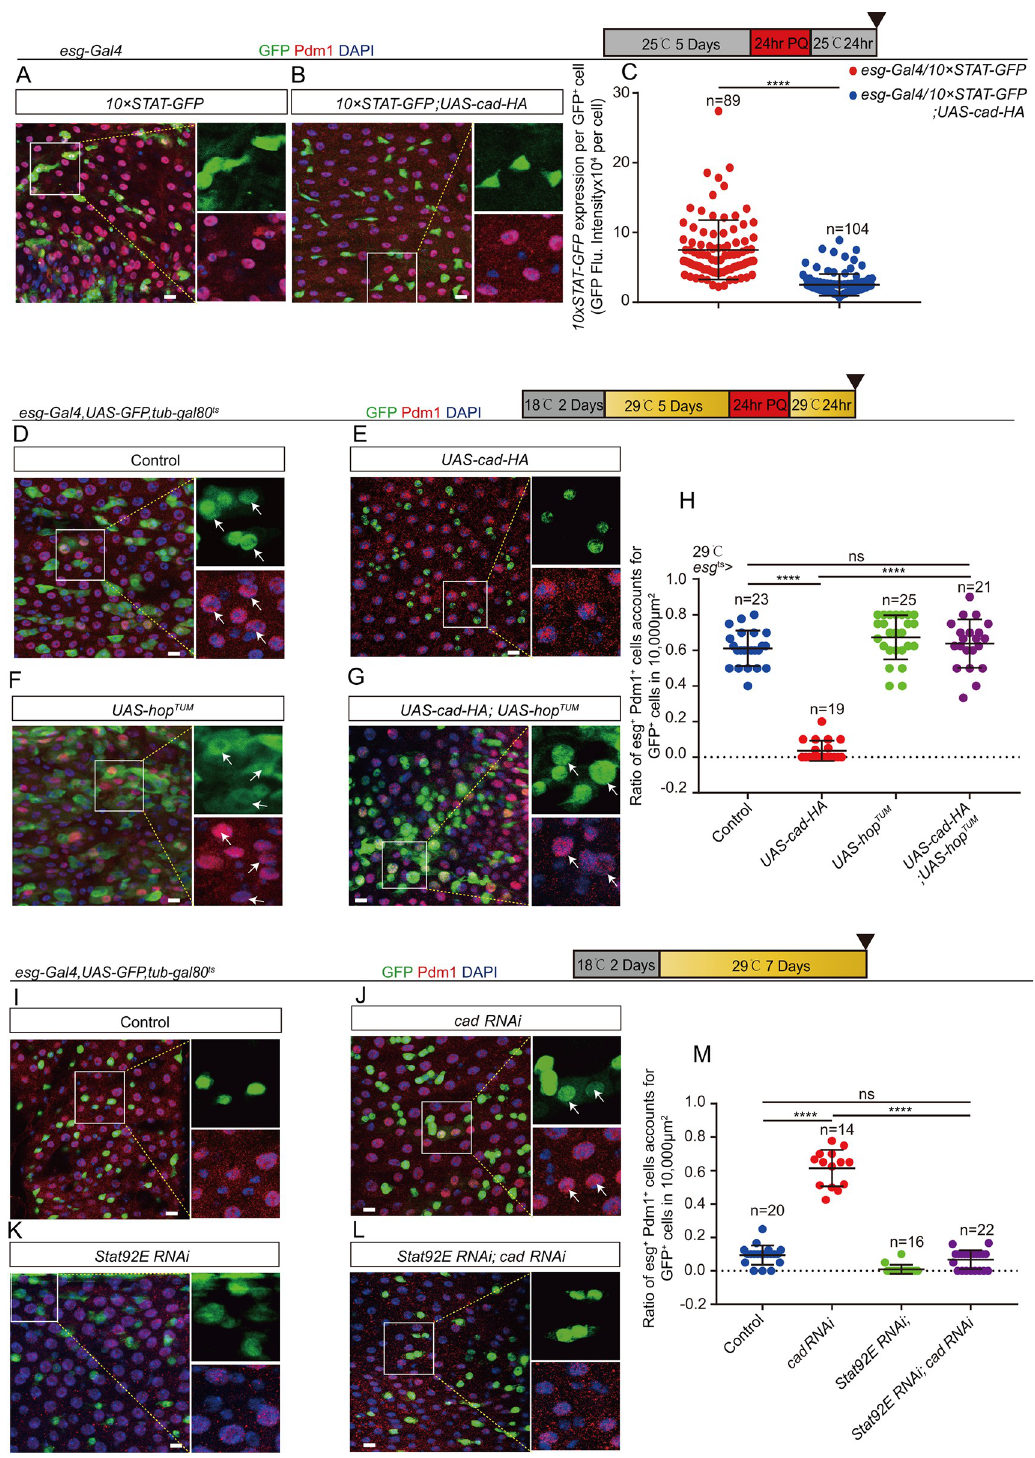
Fig 6. Cad promotes ISC-to-EC differentiation by manipulating the JAK/STAT signaling pathway. (A-B) Representative images showing the expression of 10xSTAT-GFP (green) in midguts of Drosophila carrying esg-Gal4 only (control; A) and Drosophila carrying esg-Gal4 > UAS-cad-HA (B) treated with PQ. Pdm1 (red) staining identifies pre-ECs and matured ECs. (C) Quantification of fluorescence intensity of 10x STAT -GFP per esg + cells in midguts with genotypes as indicated in (A-B). The number n represents counted cells. (D-G) Immunofluorescence images of esg -GFP (green) and Pdm1 (red) staining with